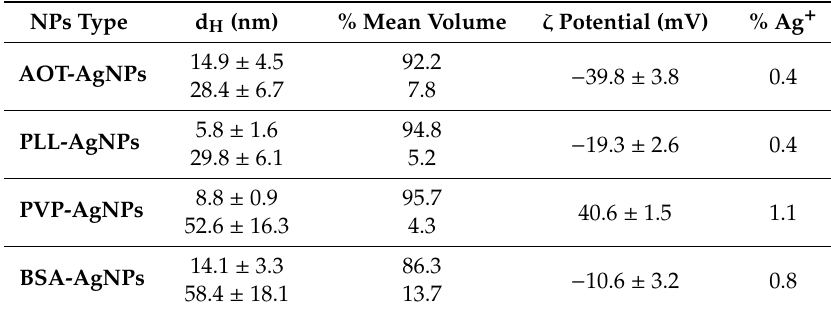
Table 1. Physico-chemical characteristics of di ff erent AgNPs. Coating agents used for stabilization were AOT, PVP, PLL and BSA. Hydrodynamic diameter ( d H , nm) values were obtained from size distributions by volume using DLS and ζ potential values (mV) were measured by ELS method. The % of free Ag + ions was measured by GFAAS in filtrates obtained by centrifugal ultrafiltration of AgNPs dispersions. All data were obtained for AgNPs dispersed in ultrapure water at concentrations of 10 mg Ag / L and at 25 ◦